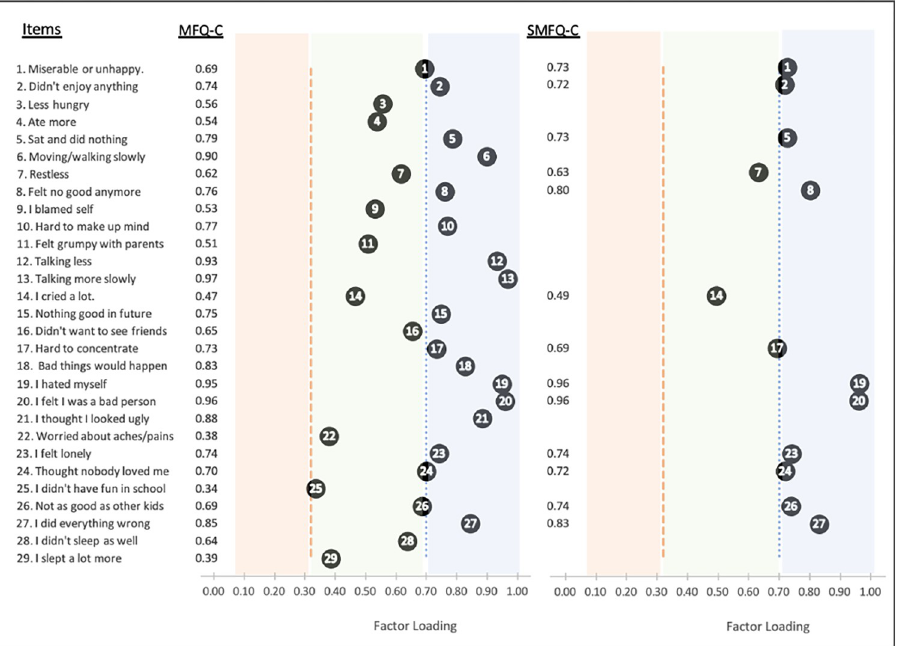
Fig 1. Factor loadings from the unidimensional confirmatory factor analysis of the modified Mood and Feelings Questionnaire (child-version, 29 items) and the Short Mood and Feelings Questionnaire (child-version, 13 items).